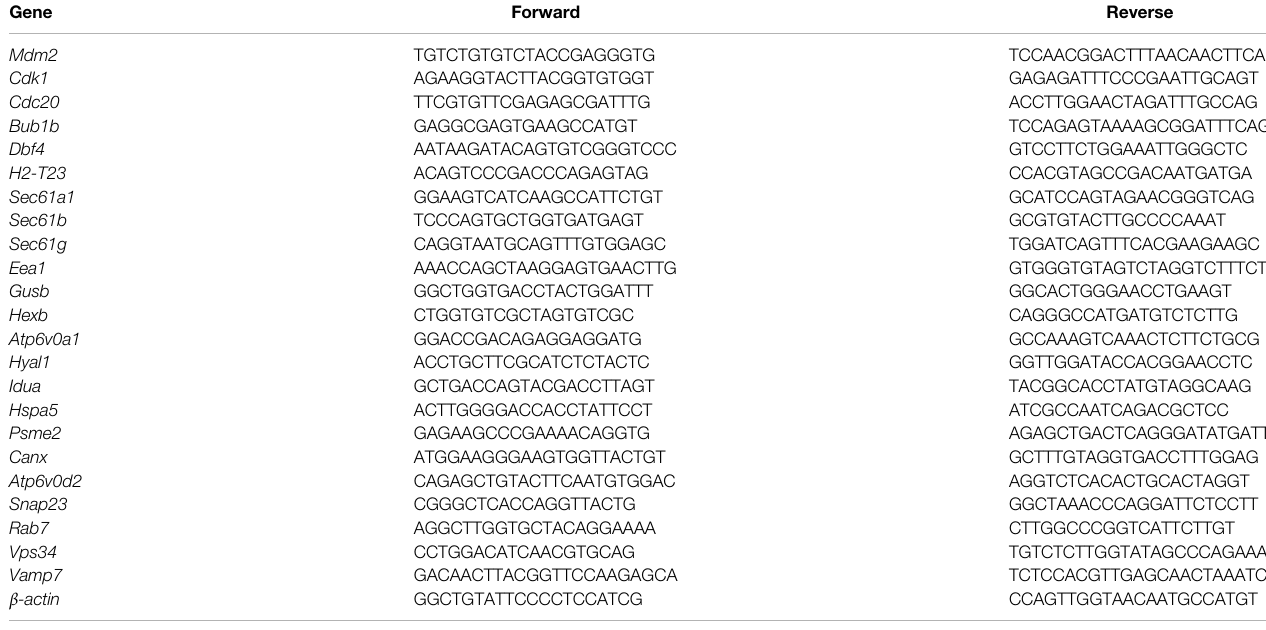
TABLE 1 | Primer sequences used for qRT- PCR. Gene